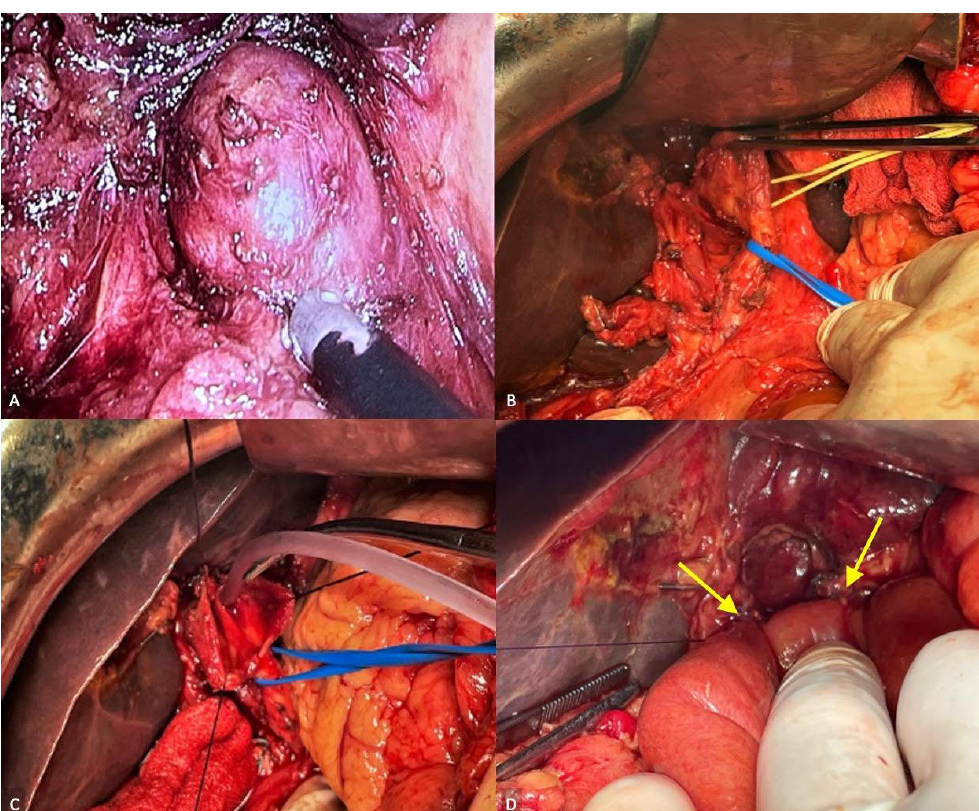
Figure 2. ( A ) CT scan, coronal section — type II CC; ( B ) MRCP reconstruction — type II CC; ( C ) ERCP — fusiform dilatation of the biliary confluence.